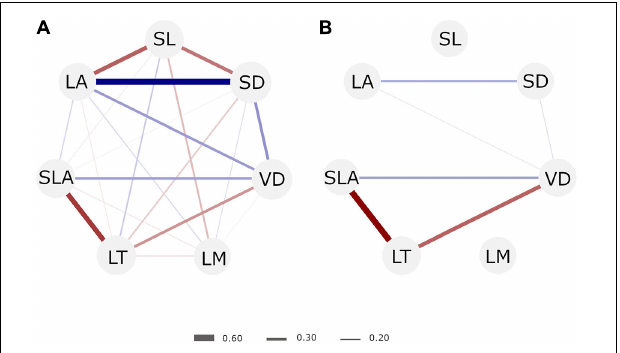
0.168 0.553 FIGURE 3 | Correlation between leaf traits (A) based on raw trait data and (B) based on the proportion of phenotypic variation attributed to the species effect (s%) that excludes the plot(environmental)-effect (see Figure 1 and section “Materials and Methods” for details). Positive correlations are denoted in blue tones and negative correlations in red tones. Correlation strengths are represented by line thickness. Only correlations with p -value below the threshold of 0.05 are shown. SL, stomata length; SD, stomata density; VD, venation density; LM, leaf dry mass content; LT, leaf thickness; SLA, specific leaf area; LA, leaf